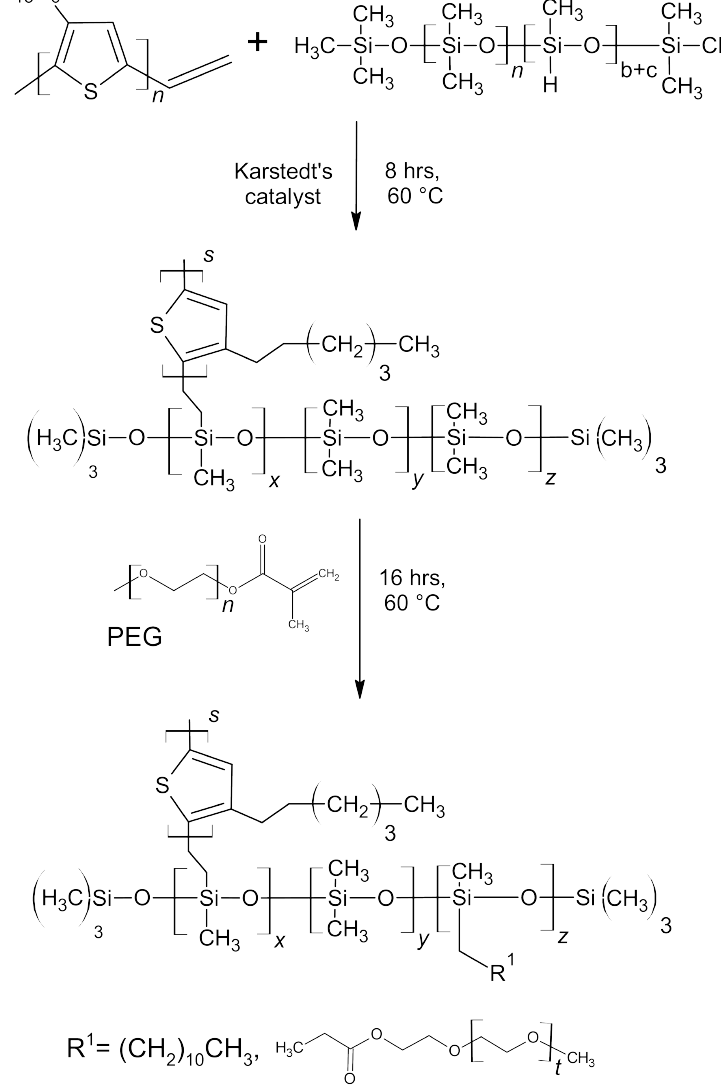
Figure 1. Scheme of the poly(3-hexylthiophenes) (rrP3HT) graft copolymer synthesis route; DodecSIL - R 1 = dodec-1-en, SilPEG - R 1 =